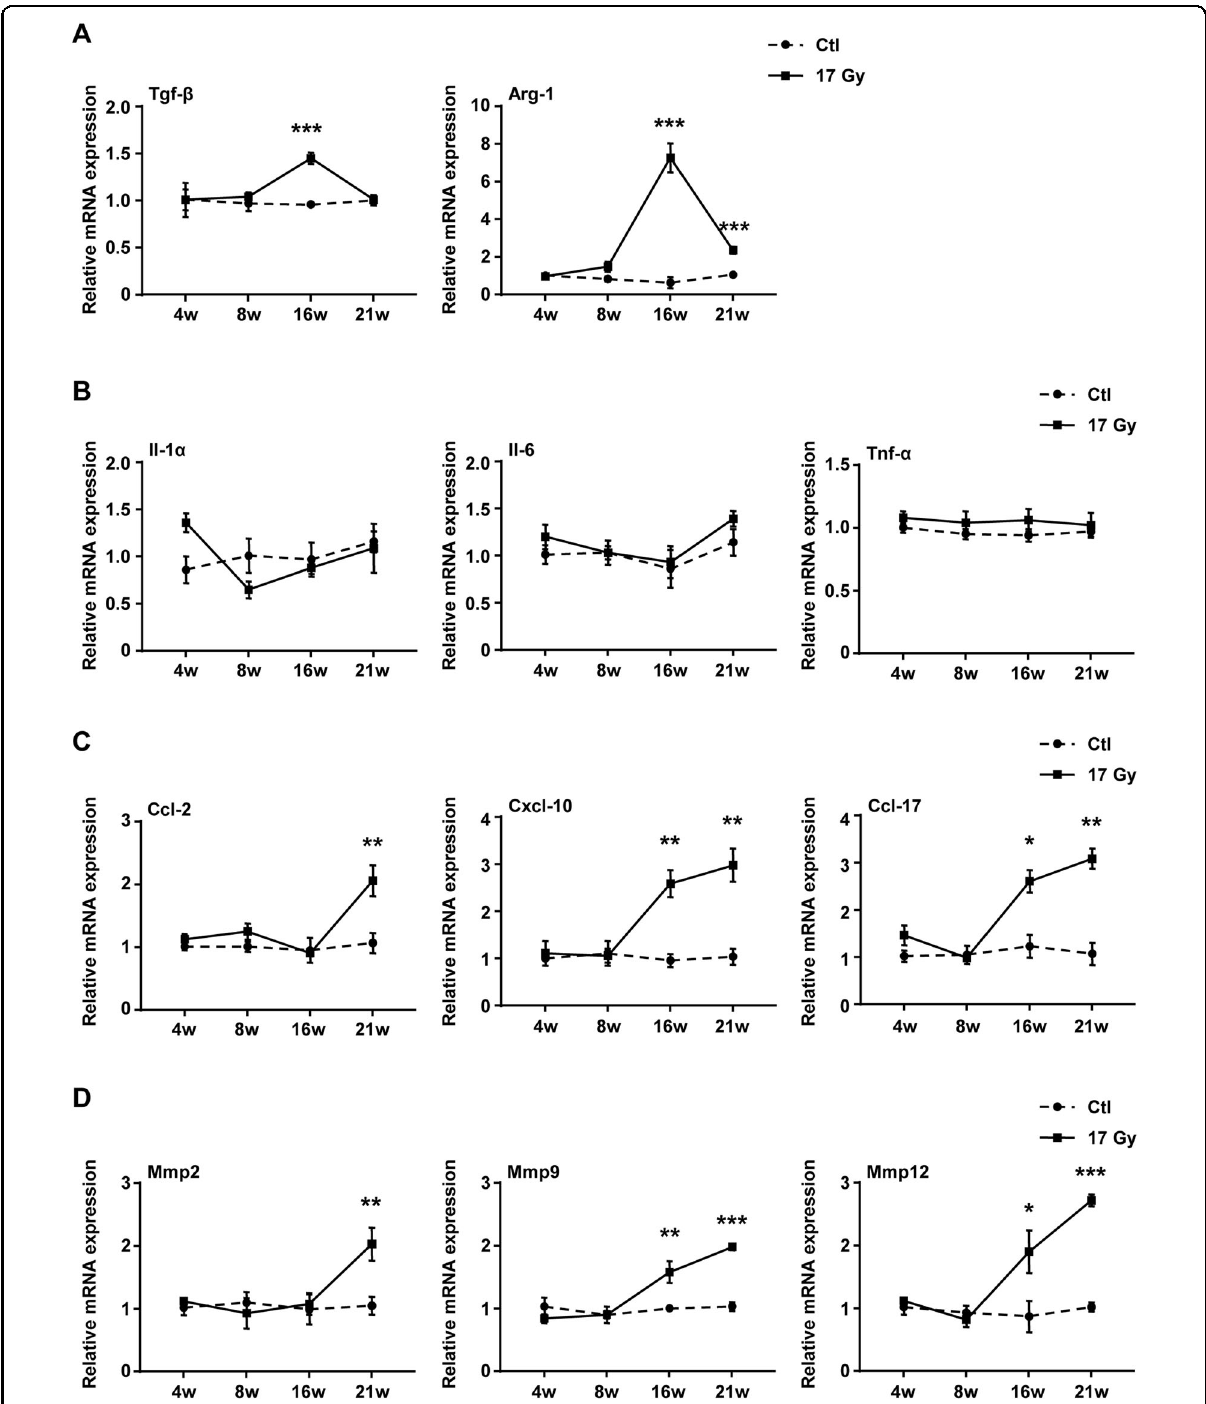
Fig. 6 Thoracic IR signi fi cantly elevated the expression of fi brotic genes and SASP genes in senescent macrophages of right lung tissue. C57BL/6J mice were exposed to a single dose of 17 Gy IR on the right side of the thorax. Samples of right lung tissue were collected at intervals after IR and in control. The macrophages were sorted by FCM. The expression of A fi brotic genes (Tgf- β 1 and Arg-1), B SASP proin fl ammatory factors genes (Il-1 α , Il-6, and Tnf- α ), C SASP chemokines genes (Ccl2, Cxcl10, and Ccl17), D SASP Mmps genes (Mmp2, Mmp9, and Mmp12) were quanti fi ed by qRT – PCR and were expressed relative to Gapdh levels in isolated macrophages. Data are expressed as mean ± SEM of six independent experiments, *** P < 0.001, ** P < 0.01, and * P < 0.05 compared with the corresponding